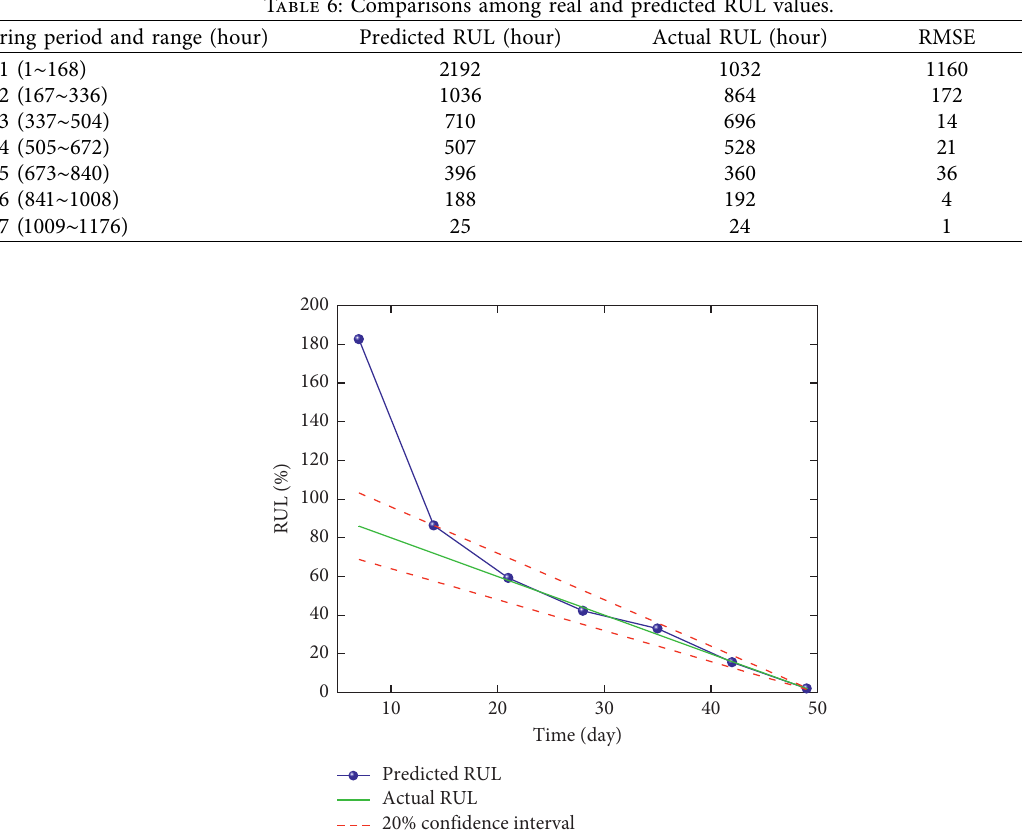
Figure 14: RUL predicting the result of the constructed